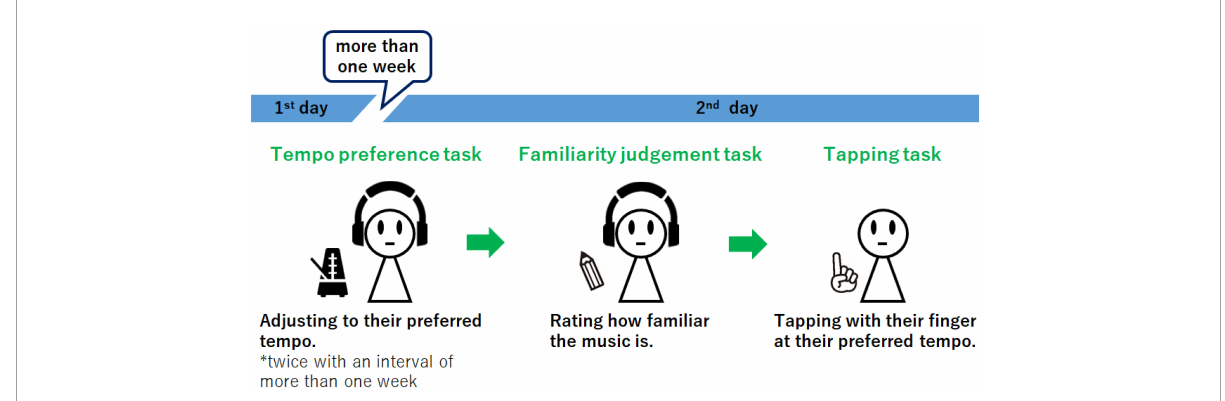
FIGURE1 Experimental design. The participants were instructed to set the presented music to their preferred tempo at two time points, separated by more than 1 week. Subsequently, they were instructed to rate the familiarity of each piece of music and completed the tapping